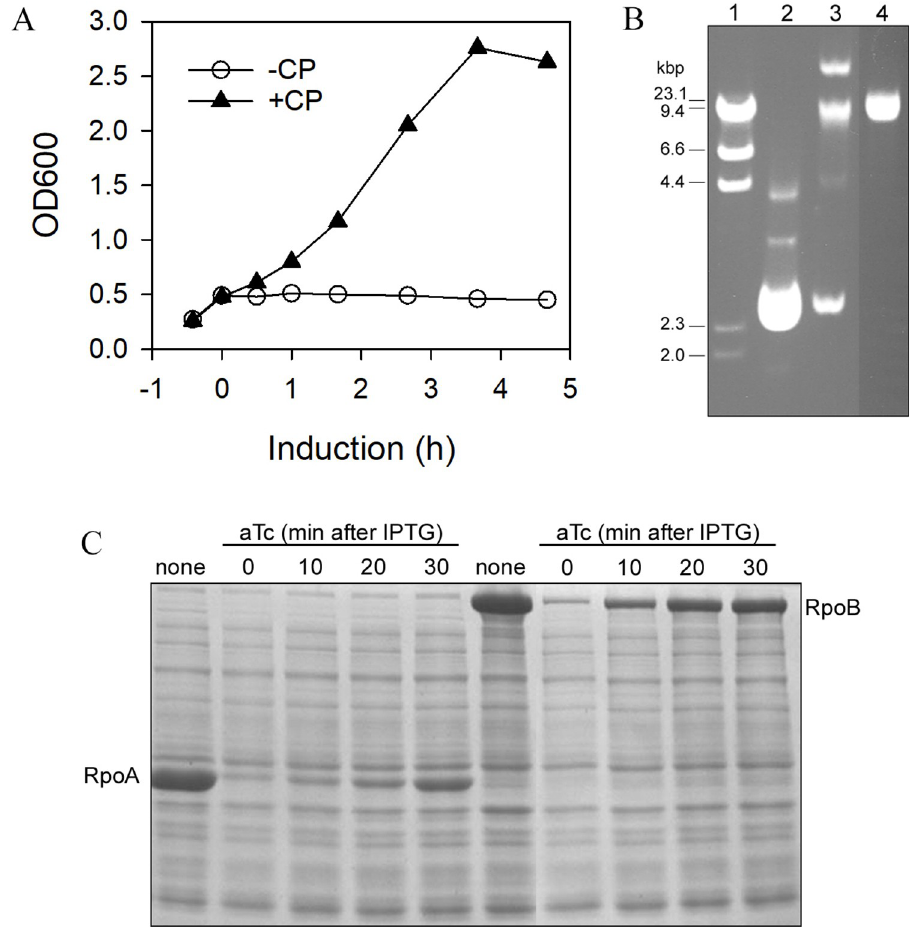
Fig 3. Effect of co-resident plasmids on the ARF48 toxic effect. A, cell growth following ARF48 induction (at T = 0) in E . coli BL21(DE3) cells transformed by pARF48 alone (-CP, open circles) or in co-transformed cells containing pARF48 and a co-resident plasmid pVS10-Sp R , which confers resistance to spectinomycin (+CP, solid triangles). Both pARF48 and pVS10_Sp R are based on ColE1 replicons and therefore belong to the same plasmid incompatibility group. B, agarose gel electrophoresis of plasmid DNA (uncut) recovered from cells that were co-transformed by pARF48 and pVS10_Sp R and grown in the presence of both selecting antibiotics (ampicillin and spectinomycin), was loaded in lane 3. Purified samples of pARF48 and pVS10_Sp R DNA (uncut) were loaded in lanes 2 and 4, respectively, and migrated at the expected sizes (3.2 kb and 15.2 kb, respectively). Phage lambda DNA digested with HindIII was loaded in lane 1, and the sizes of restriction fragments is indicated at left. C, E . coli BL21DE3 cells co-transformed by pARF48 and pACYC-pET-based expression plasmids for either RpoA or RpoB, which belong to a different plasmid incompatibility group, were grown to early log phase and then treated with Isopropyl β -D-1-thiogalactopyranoside (IPTG) at time 0 to induce expression of RpoA or RpoB proteins ( E . coli RNA polymerase α and β subunits, respectively). After incubation for 0, 10, 20 or 30 min, samples of each culture were treated with aTc to induce ARF48 expression. After further incubation for 2 h, an equal number of cells from each culture was lysed and the lysates were electrophoresed in an SDS-polyacrylamide gel which was then stained with Coomassie blue. Samples from cultures not treated with aTc were loaded in lanes 1 and 6. The positions of RpoA and RpoB proteins in the gel are indicated. The corresponding growth curves for this experiment are shown in S3